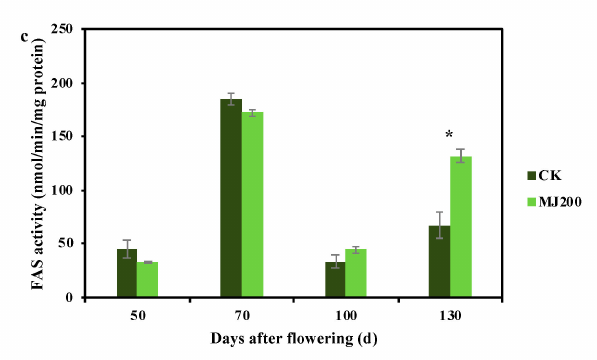
Figure 1. Effects of MJ200 on CF mass fraction and FA synthesis-related enzymes’ activity during seed development. ( a ) CF mass fraction in S. tonkinensis seeds at 50, 70, 100 and 130 DAF; ( b , c ) ACC and FAS activities in S. tonkinensis seeds at 50, 70, 100 and 130 DAF. Data points showed mean ± SD; * indicated significant difference ( p <